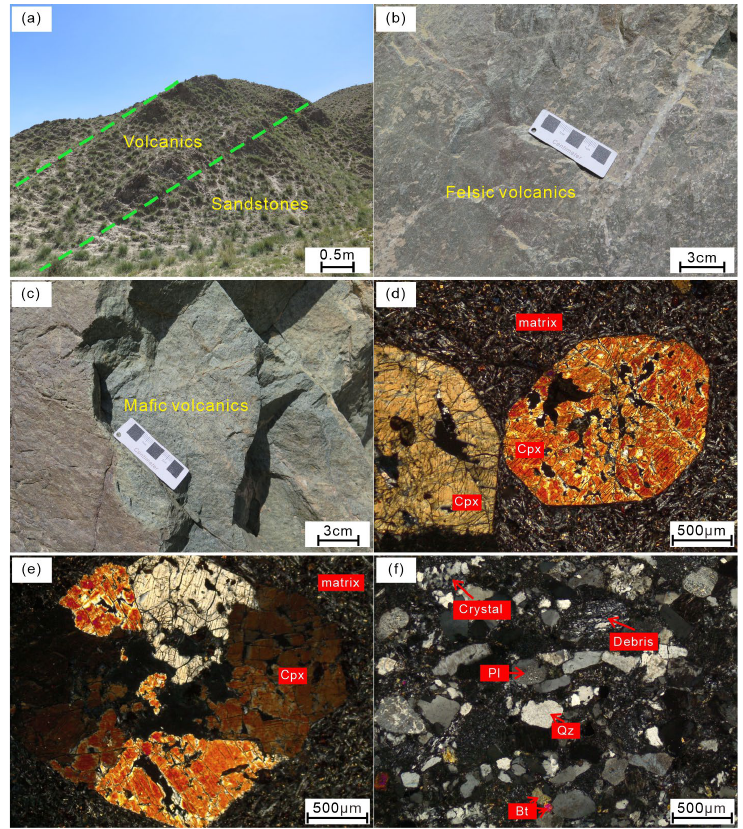
Figure 4. Maoniushan Formation volcanic rocks outcrops and photomicrographs. ( a ) Volcanic outcrop; ( b ) Felsic volcanic rocks outcrop; ( c ) Basalt outcrop; ( d ) Basalt micrograph and porphyritic structure; ( e ) Porphyritic structure and cross interpenetration twinning; ( f ) Microscopic features of felsic volcanic rocks. Minerals abbreviation: Cpx—clinopyroxene; Qz—quartz; Pl—plagioclase;